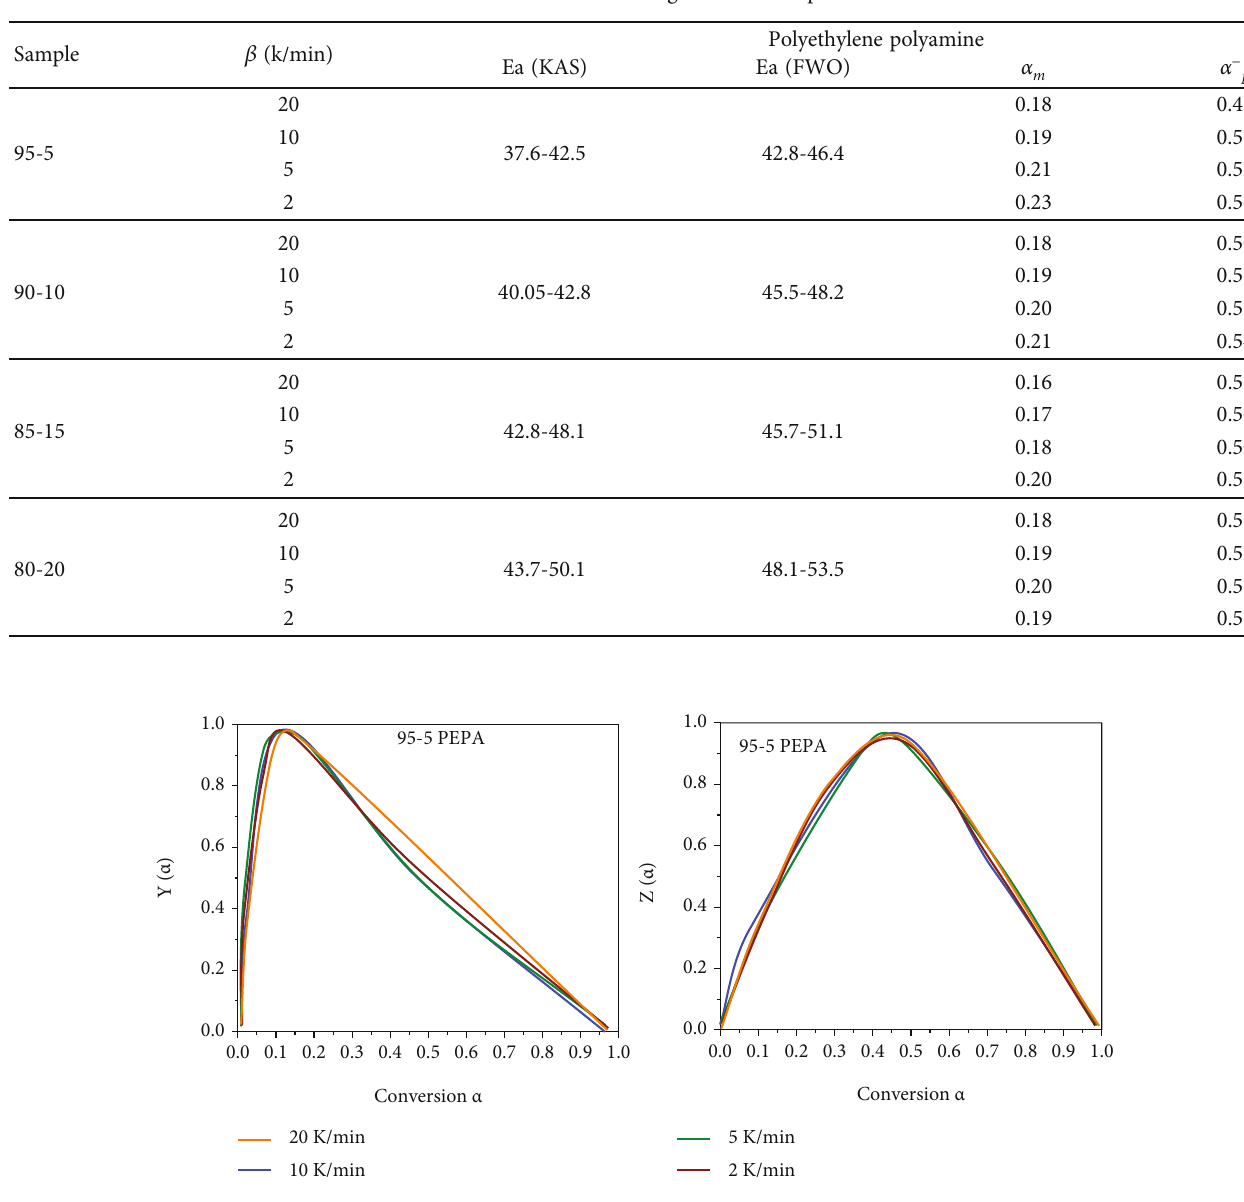
Table 3: Overall activation energies for all compositions.